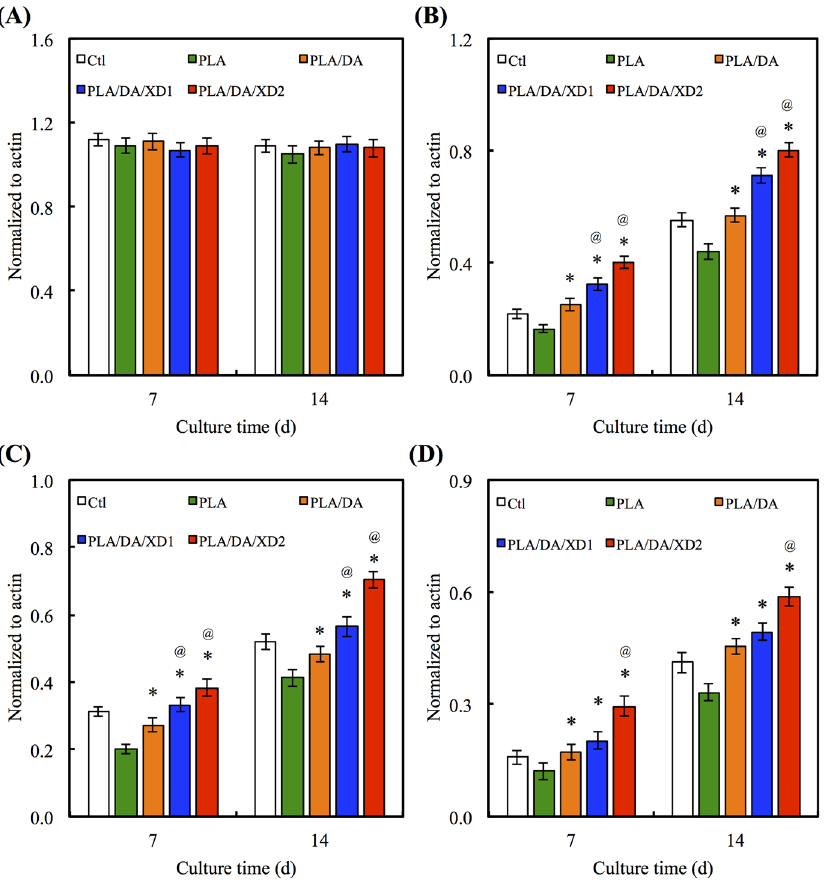
Figure 9. ( A ) Col; ( B ) ALP; ( C ) BSP and ( D ) OC gene expression in the hBMSCs